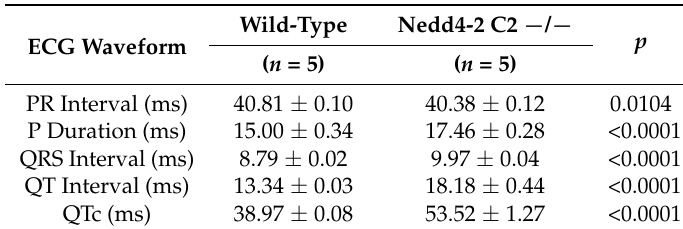
Figure 1. Representative surface electrocardiogram (ECG) traces recorded in wild-type and neural precursor cell-expressed developmentally downregulated gene 4-2 (Nedd4-2) C2-knockout mice. Representative ECG traces from wild-type ( A ) and Nedd4-2 C2-knockout mice ( B ). Table 1. Comparison of electrocardiographic findings between wild-type and neural precursor cell-expressed developmentally downregulated gene 4-2 (Nedd4-2) C2-knockout mice. Male wild-type littermates ( n = 5; 8–9 weeks old) and Nedd4-2 C2 − / − mice ( n = 5; 8 weeks old) were used in this experiment. Data are expressed as means ± standard errors (SE). Nedd4-2 C2-knockout mice showed a shorter PR interval than wild-type mice. P-wave duration in Nedd4-2 C2-knockout mice was longer than that in the wild-type mice. Moreover, prolonged QRS, QT and QTc were found in Nedd4-2 C2-knockout mice.